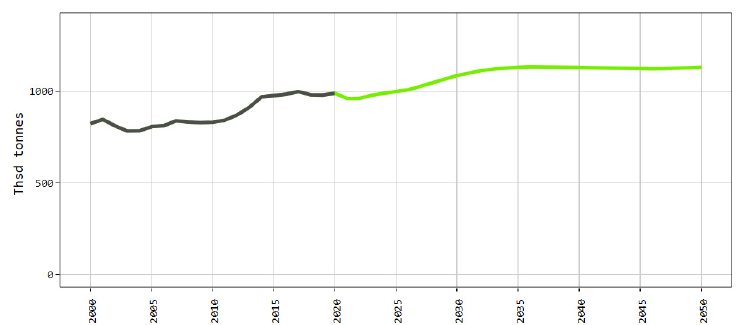
Figure 12. Milk production in Latvia in 2000–2020, with a projection for 2021–2050, in thousands of tons [62].